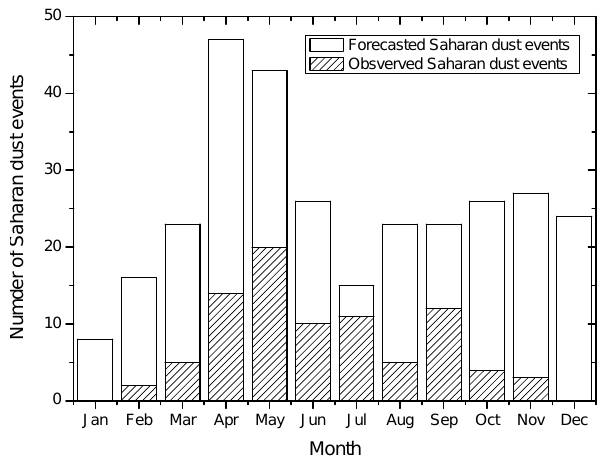
Fig. 2. Number of days per month in which strong Saharan dust intrusions are observed over Athens during 3 years of lidar mea- surements (January 2004–December